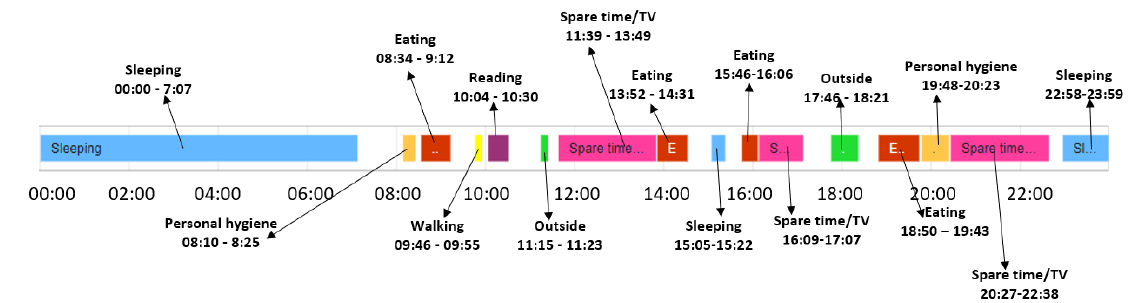
Figure 11 illustrates for the older adult M1 the activities from the date 10 February 2021, Figure 10. Example of day with activity sequence anomalies for the older adult M1. which has been classified as a day with activity duration anomalies. If the duration similar- ity is higher than the confidence duration, then the day conforms to the learned baseline, without any significant deviations (e.g., days February 8 and February 9 in Figure 9).